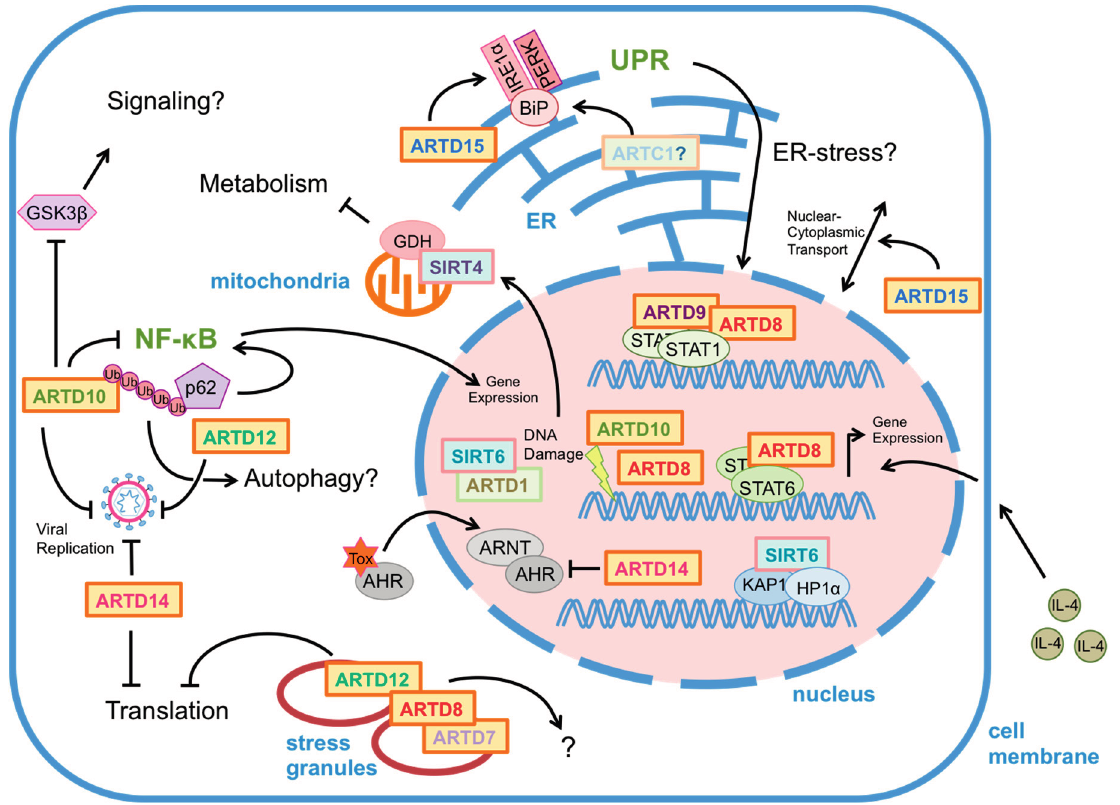
Figure 1. Functions of mono-ADP-ribosylating ARTD (ADP-ribosyltransferase diphtheria toxin-like) enzymes and of mono-ADP-ribosylating Sirtuins in signaling.